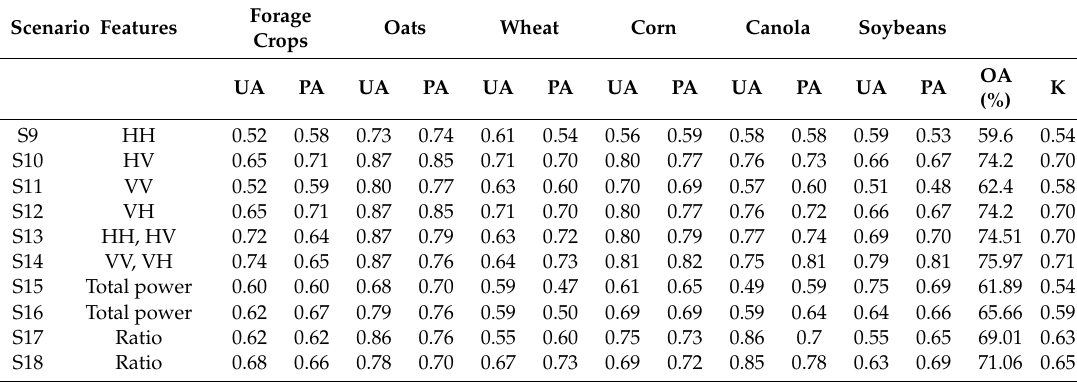
Table 6. Classification results obtained from extracted features from simulated DP SAR data at a noise floor (NF) of − 19 dB (see Table 3 for an exact description of extracted features in this table).